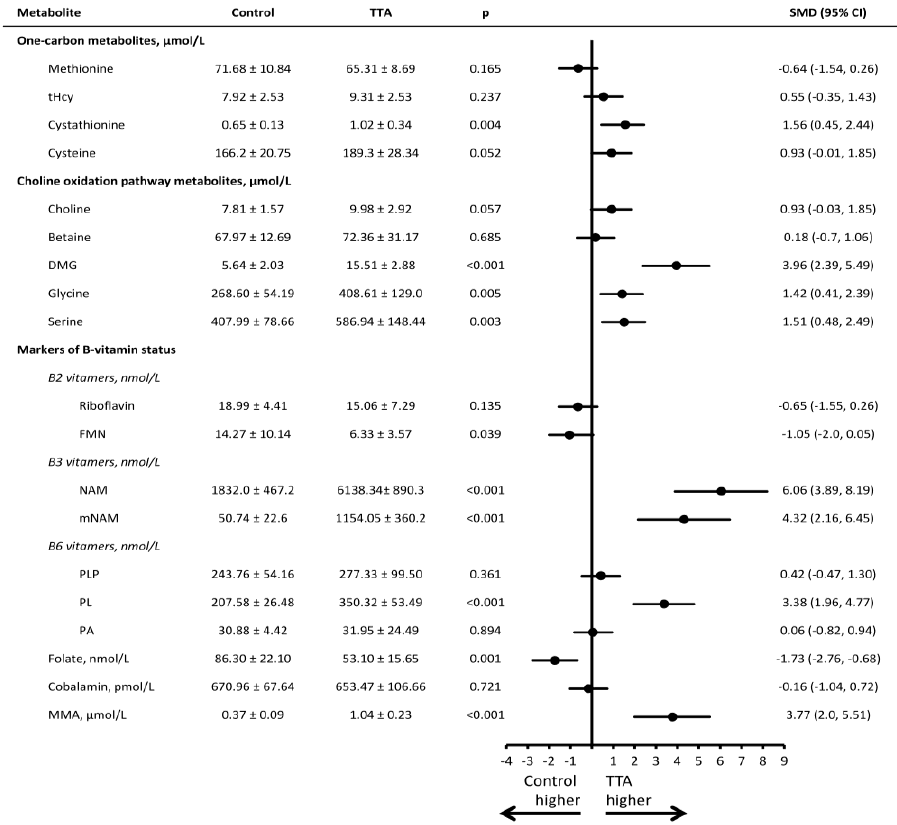
Figure 2. Plasma concentrations of metabolites in rats receiving a high fat control diet or a high fat diet with additional TTA treatment. Male Wistar rats were treated with a high-fat diet with or without additional TTA treatment, n = 10 in each group. Mean (SD) plasma concentration of the metabolites, as well as the standardized mean difference (95% CI) between the control and the TTA treated animals. DMG indicates dimethylglycine; FMN, flavin mononucleotide; MMA, methylmalonic acid; mNAM, N1-methylnicotinamide; NAM, nicotinamide; PA, pyridoxic acid; PL, pyridoxal; PLP, pyridoxal-5’-phosphate; SMD, standardized mean difference; tHcy, total homocysteine; TTA, tetradecylthioacetic